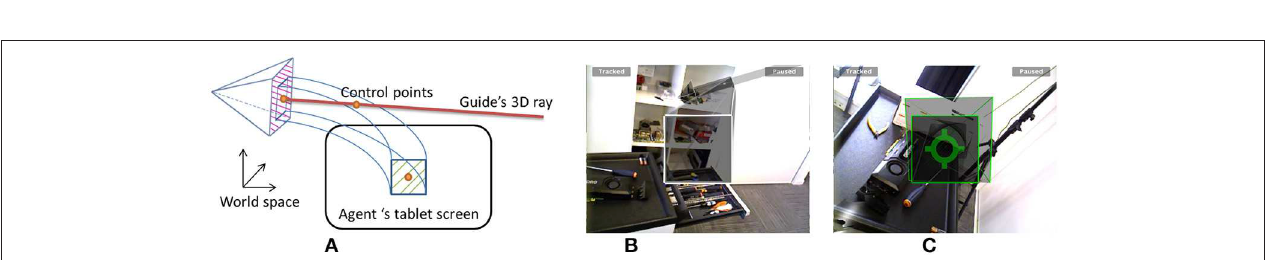
FIGURE 14 | Squared guiding arrow principle controlled by the expert’s 3D ray in dynamic mode. (A) Scheme of the control principle, constrained by three control points; (B) the agent’s display showing a PoV to reach dynamically controlled by the expert’s 3D ray (seen on the top right of the screenshot); (C) the agent has reached the pointed spot, and the base and the end squares of the arrow are aligned and almost superposed. Notice that the green reticule in the center of the base square shows a potential additional cue that used in combination with the proposed technique. This acts as a flickering proximity sensor to improve the agent’s fine positioning. We did not enable this additional feature for the pilot user study in order to evaluate performances of our proposed technique removing other helping